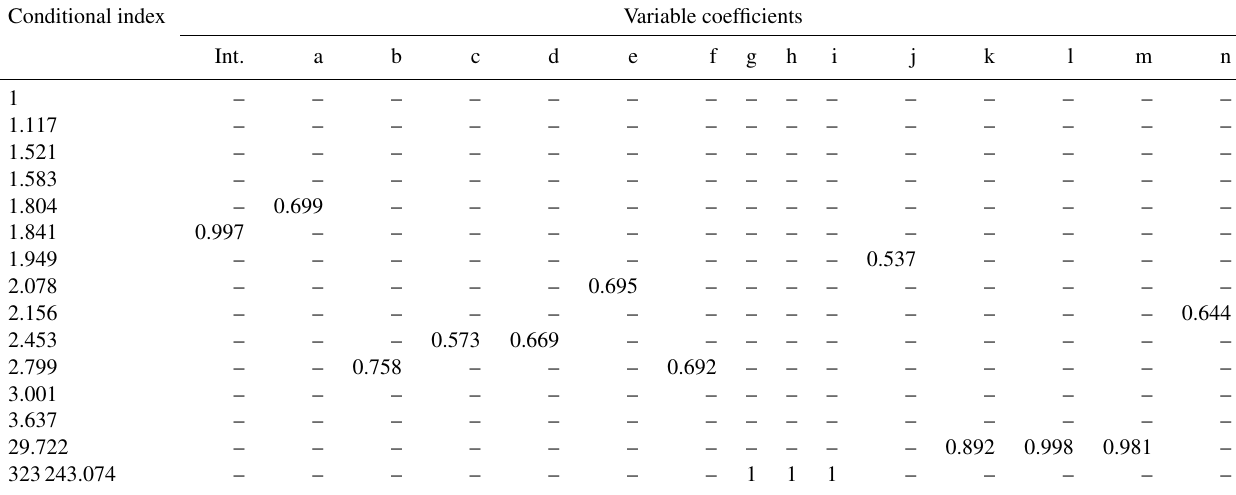
Table 2. Multicollinearity table generated by LAND-SVA for the Gipuzkoa study area.